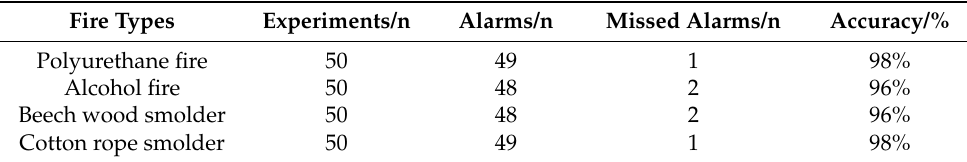
Table 8. A comparison of the real situation and system recognition.